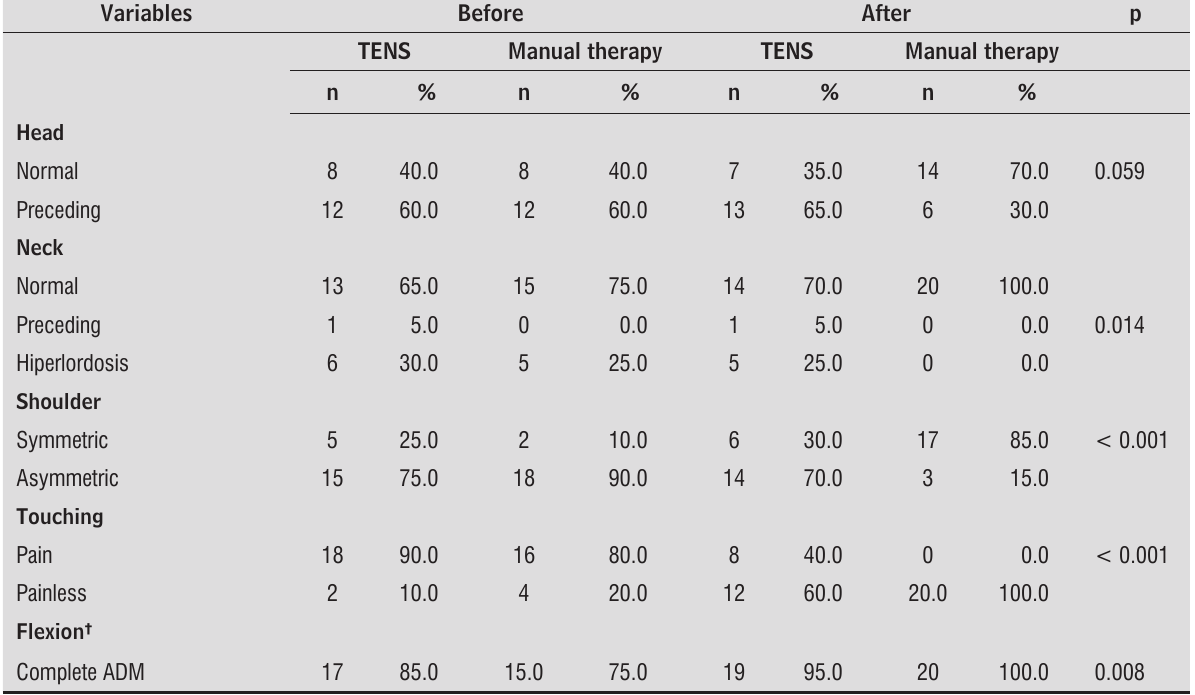
Table 3 - Comparison between TENS and manual therapy accordingly posture and clinical movement variable amplitude